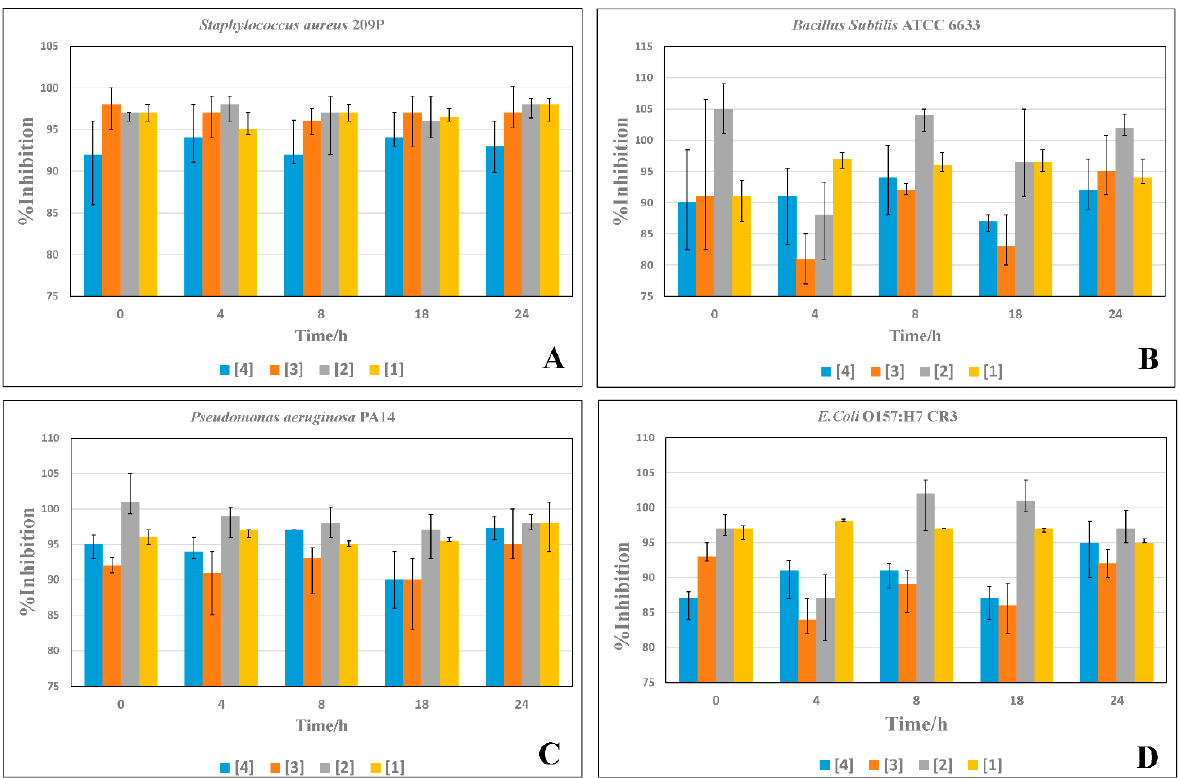
Figure 3. Time-inhibition assays of the newly-synthesized AMPs against the selected bacterial strains ( A – D ). The results described in Figure 4 show the inhibition of the bacterial growth in the tested samples compared with the controls before incubation. We can see that (2) showed relatively high activity (except for S. aureus ), as it could inhibit the growth of P. aeruginosa and B. subtilis completely, while the %growth of the other bacteria was about 3%. According to the activity, (1) came in second place, except for against S. aureus , for which it showed the same efficacy as (2).In addition, (3) came in third place according to its activity against all bacteria except for S. aureus ; it was the most active peptide, as its associated bacterial growth was about 2%. While (4) showed a good antibacterial activity, it was relatively lower than the other peptides except for P. aeruginosa ; it was more active than (3).